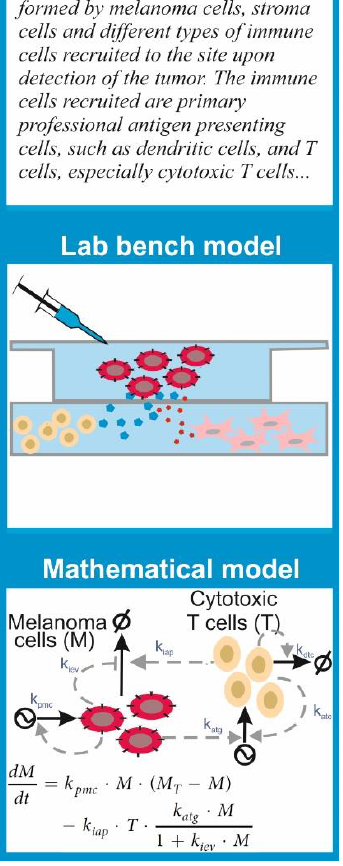
Figure 1. Science employs different types of models to represent natural systems. Let us suppose that we are interested in investigating the properties and potential vulnerabilities of a melanoma metastasis (here, the “ natural system ”, visualized with MELC microscopy as in Ostalecki et al. 2017 [1]). One can represent the natural system with a semantic model , that is, the verbalization in natural language of the key compounds and processes as well as the hypotheses about a melanoma micrometastasis. Under some simplifying assumptions, a melanoma metastasis can be studied with lab bench models. For example, if one is interested in the interplay between cancer and immune cells, it is possible to co-culture tumor cells with relevant types of immune cells in vitro, like in Vescovi et al. 2019 [2]. In most cases, an alternative option is mathematical models, that is, sets of parametric equations that encode the key properties of metastasis and the hypotheses. The mathematical model is the basis for computational simulations to design experiments or to formulate or explore hypotheses like in Santos et al. 2016 [3].